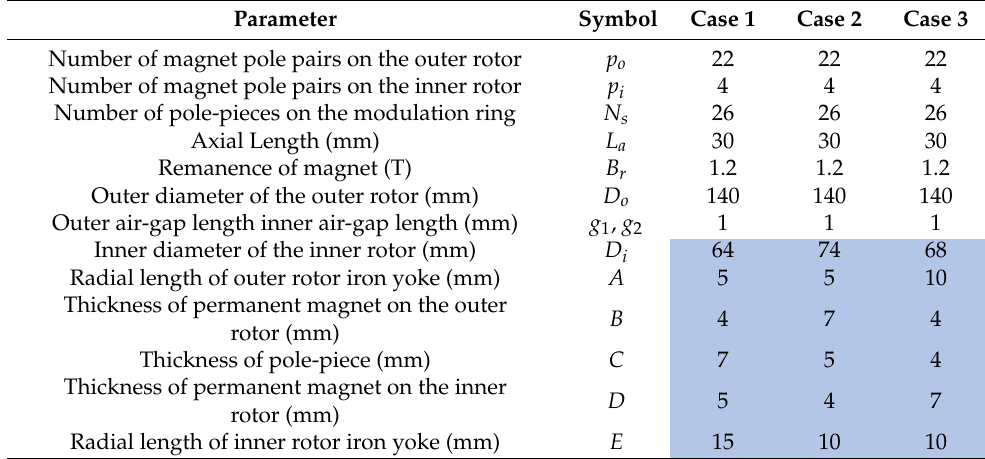
Table 3. Three cases of CMGTs. Parameter Symbol Case 1 Case 2 Case 3 Number of magnet pole pairs on the outer rotor p o 22 22 22 Number of magnet pole pairs on the inner rotor p i 4 4 4 Number of pole-pieces on the modulation ring N